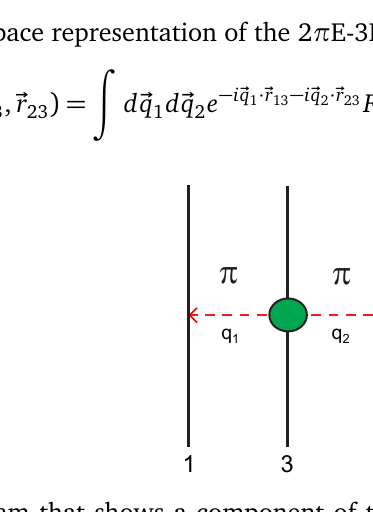
Figure 1: Diagram that shows a component of the 2 π E-3NP. Total 2 π E-3NP is the sum of cyclic permutations of this